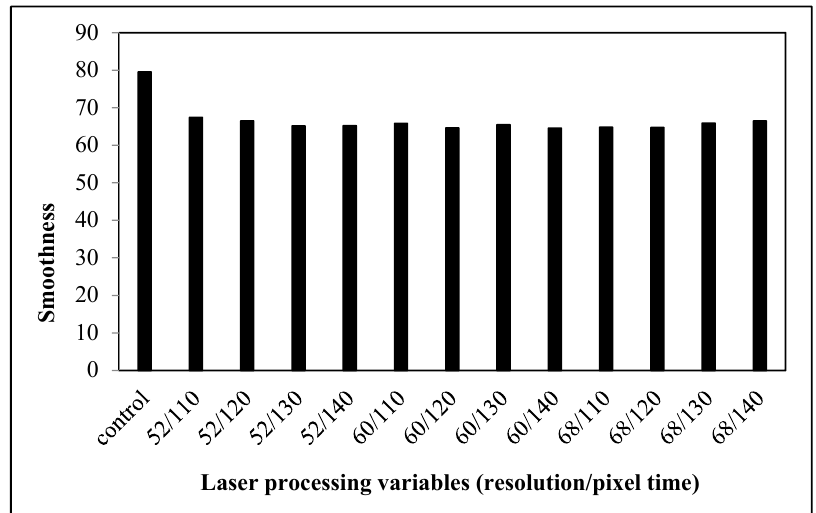
Figure 9. Relationship between laser processing variables and the smoothness of cotton/polyester blended fabric.